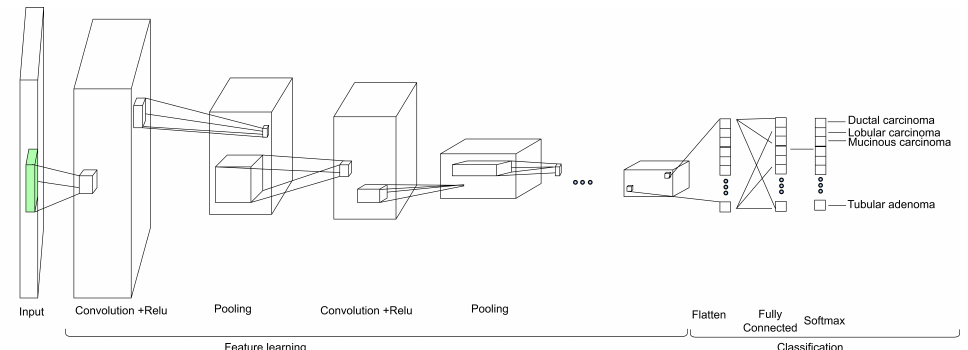
Figure 2. Architecture of a convolutions neural network (CNN)